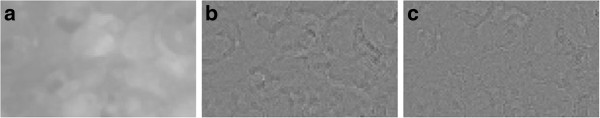
Registration example using wavelet filtering. a) Differences of misaligned frames at two different wavelengths. b) Differences of the first wavelet layer, same images (Std dev: 0.025). c) Differences of the first wavelet layer, after registration (Std dev: 0.021).